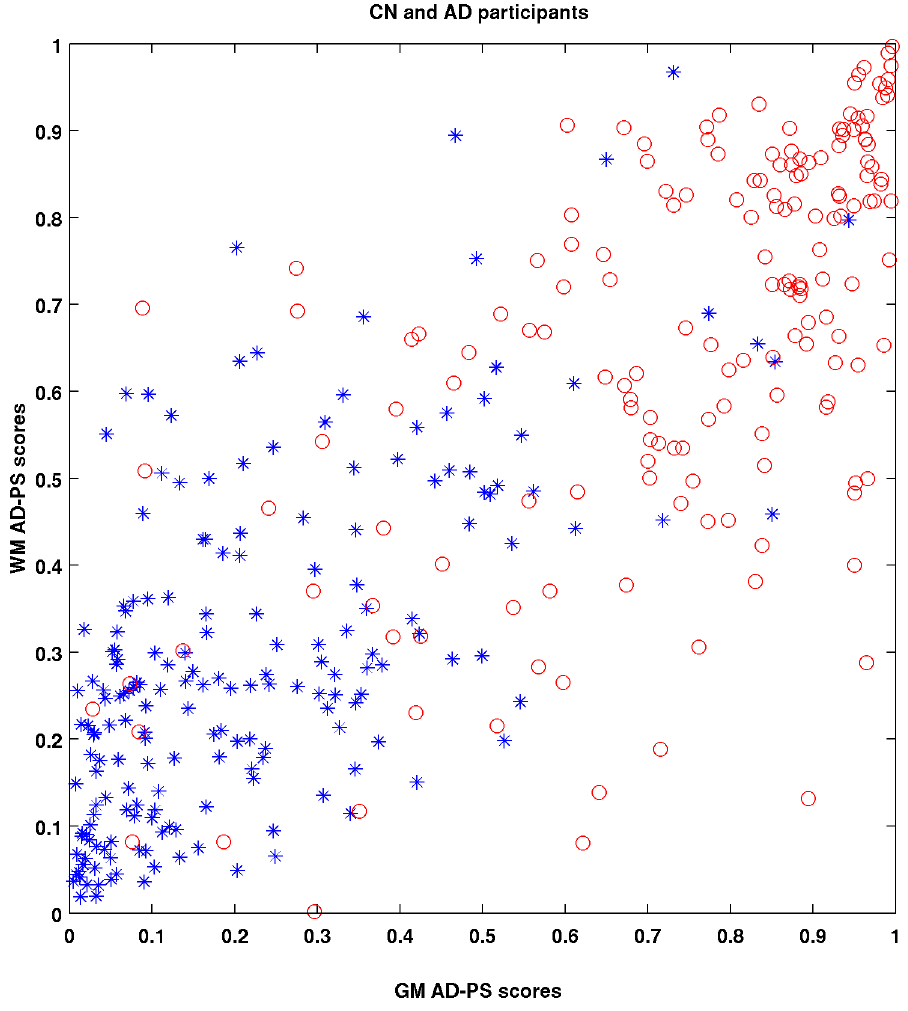
Figure 4. Two-dimensional probabilistic hypercube views of ADNI data showing AD-PS grey matter (GM) and white matter (WM) scores for 188 cognitively normal (CN – blue stars) and 171 Alzheimer’s disease (AD) patients (red circles). They tended to cluster in different corners, as expected.